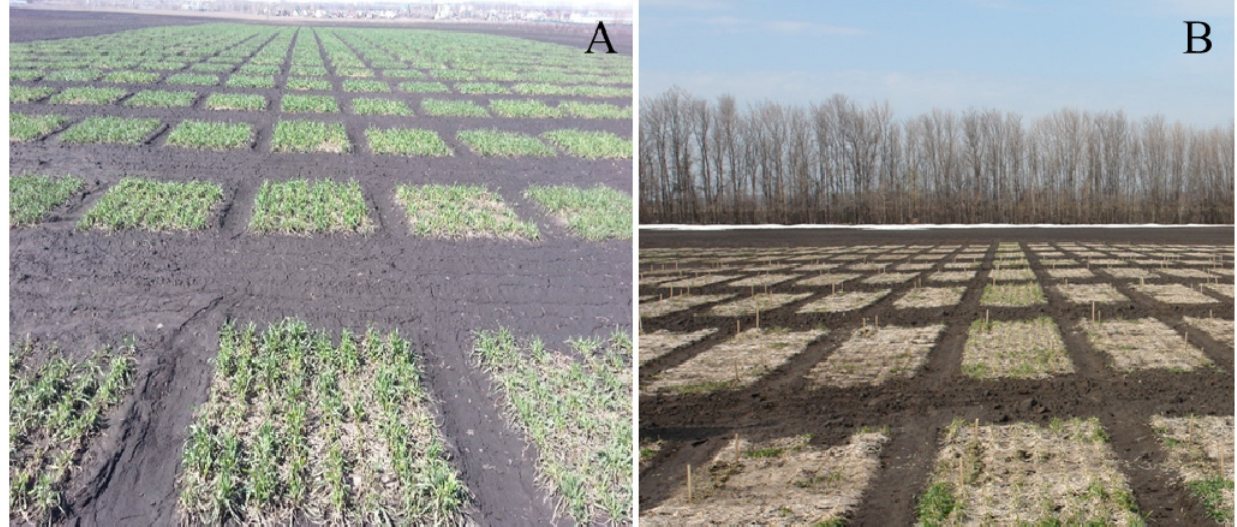
Figure 6. Rye plots in the nurseries with a natural infection background (NIB) ( A ) and with an